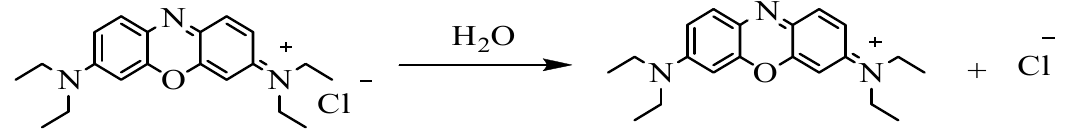
Scheme 3. Dissociation of BB3 in a positively-charged complex cation and negatively charged chloride ion